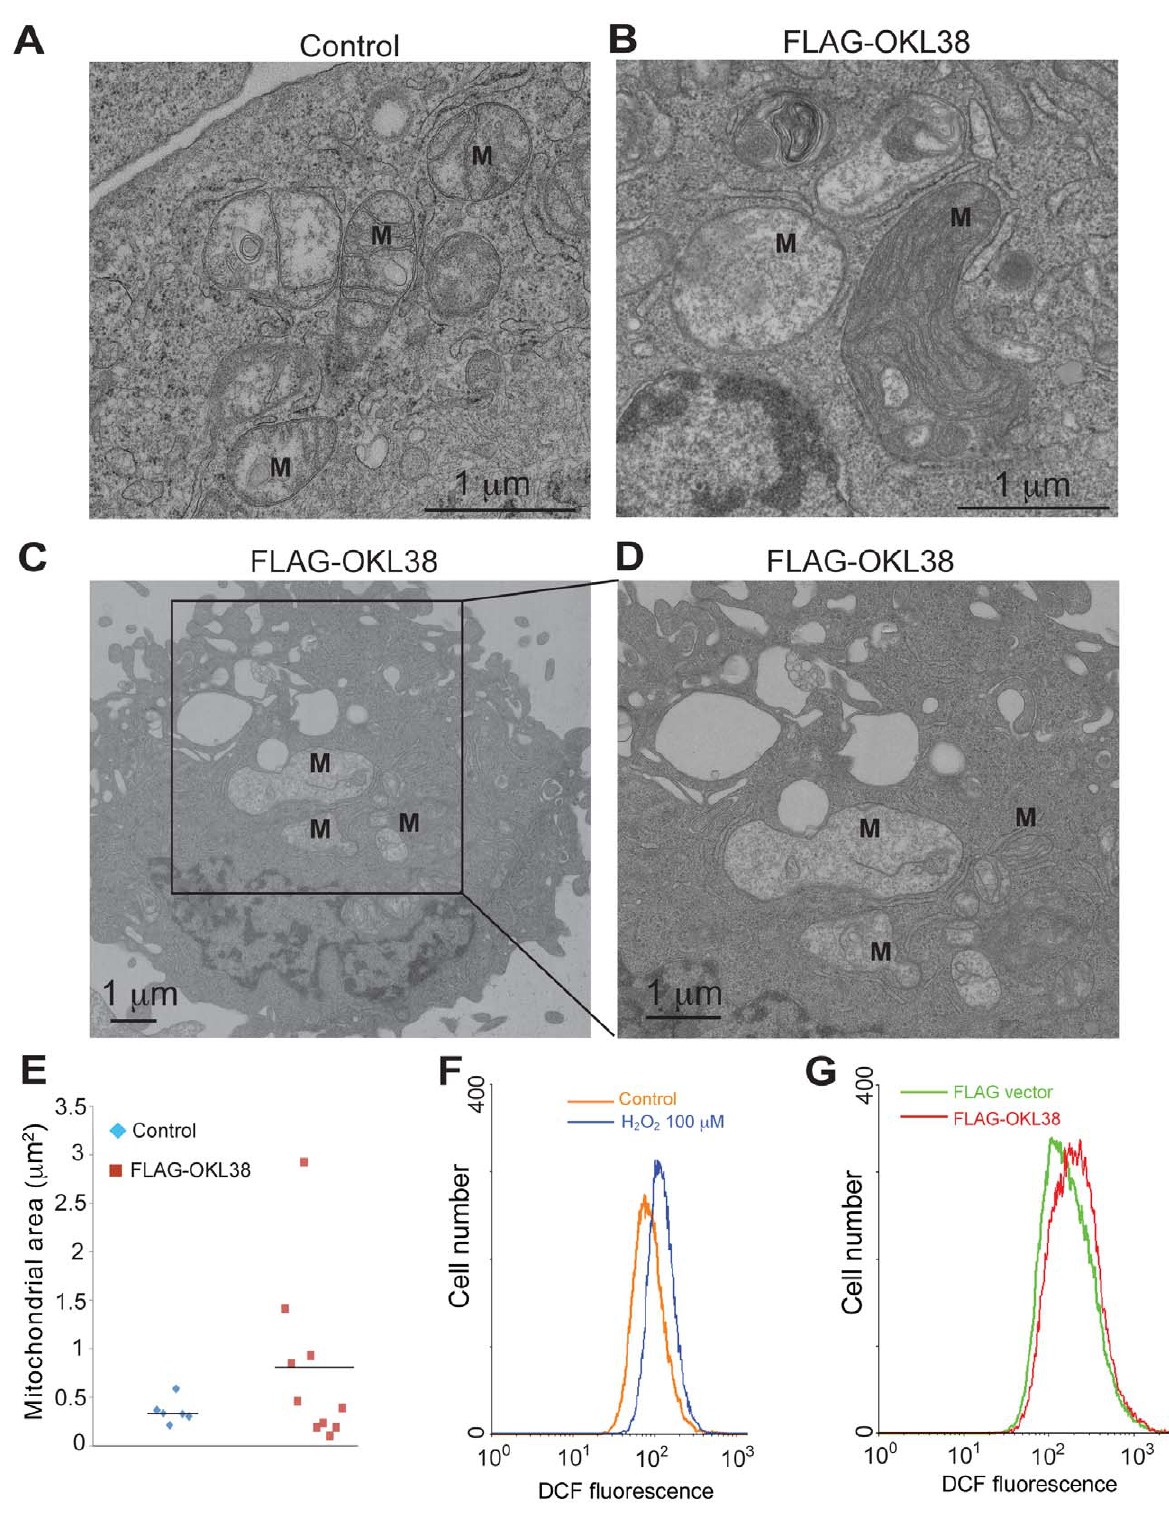
Figure 5. OKL38 expression induced formation of megamitochondria and ROS production. (A) Ultrastructure analyses of mitochondria (M) using TEM in U2OS cells. (B–D) Ultrastructure analyses of mitochondria (M) in U2OS cells after OKL38 expression. Note the enlargement of mitochondria and the alteration of cristae structures. (E) The surface mitochondria areas in TEM images were analyzed by NIH image J program. The occurrence of megamitochondria was only observed in U2OS cells after OKL38 expression. (F) Flow cytometry analyses of cellular ROS levels in U2OS cells after H 2 O 2 treatment. (G) Flow cytometry analyses of cellular ROS levels after FLAG-OKL38 expression. The DCF fluorescence signals were increased after H 2 O 2 treatment or FLAG-OKL38 expression.